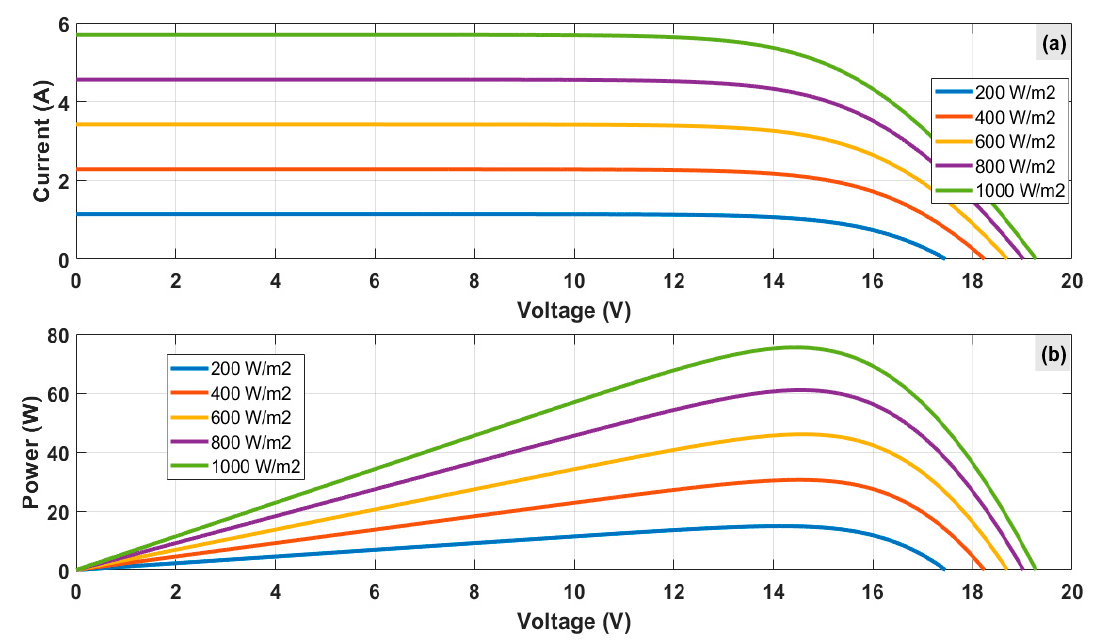
Figure 6. Characteristics curve of the proposed SM-85KSM PV module for different solar irradiance at 25 °C. ( a ) I–V (current–voltage) curve ( b ) P–V (power–voltage) curve.